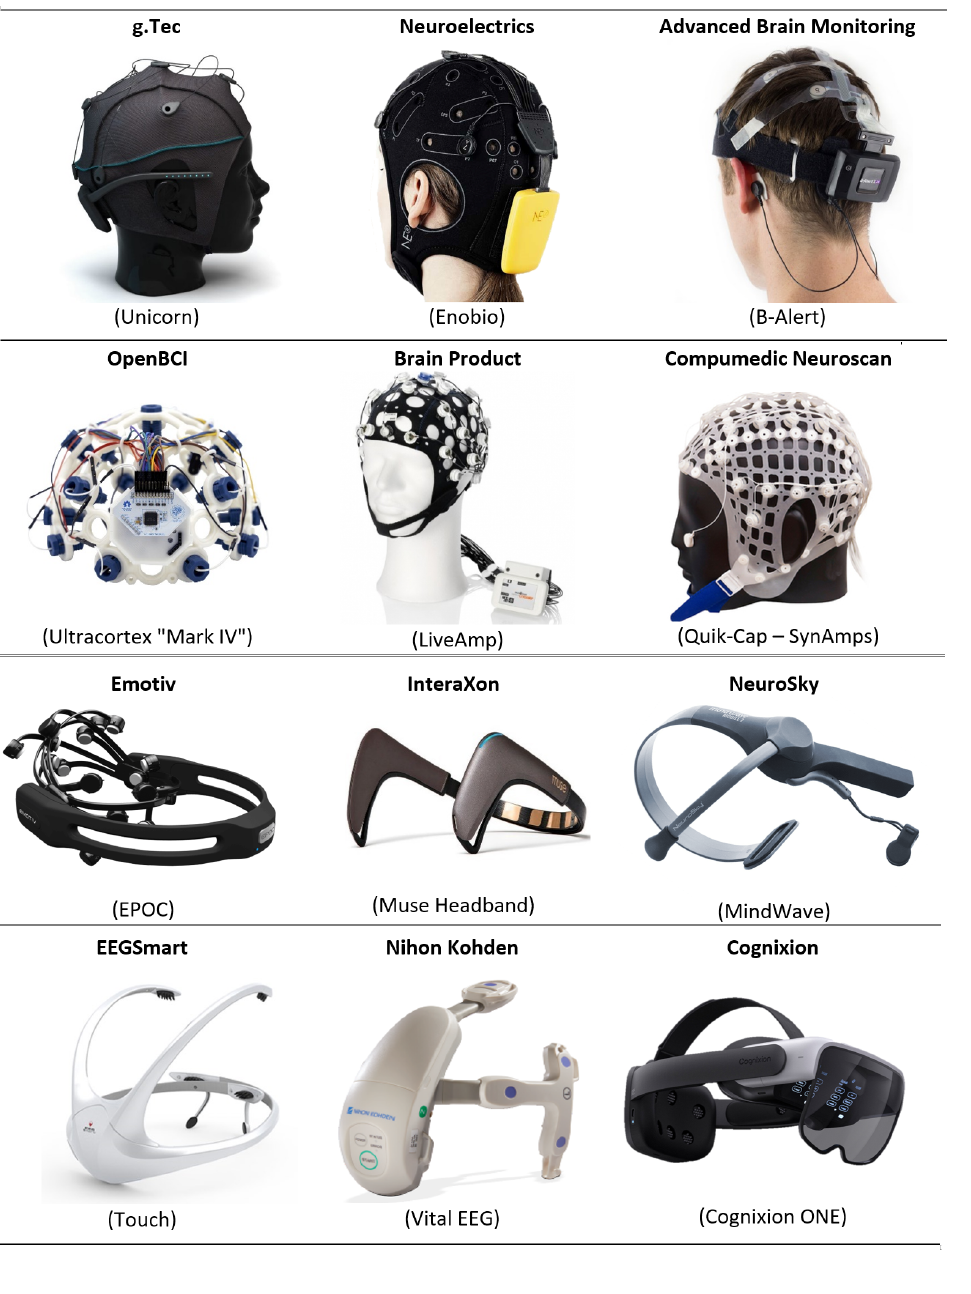
Figure 2. Examples of the commercial noninvasive EEG equipment based on the BCI technology. EEGSmart, Nihon Kohden, and Cognixion refer to the future noninvasive EEG